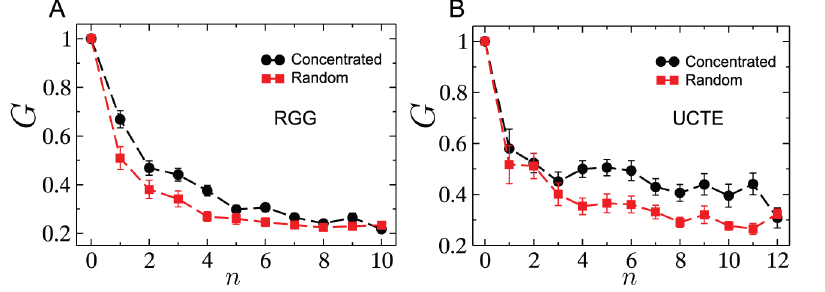
Figure 15. Cascades triggered by concentrated versus randomly distributed removals. (A) Fractional surviving giant component size after a cascade as a function of number of initial nodes removed in concentrated and random removals for RGGs with N ~ 1500 and S k T ~ 6 . (B) Fractional surviving giant component size after a cascade as a function of number of initial nodes removed in concentrated and random removals for the UCTE network. Each data point is an average over more than 25